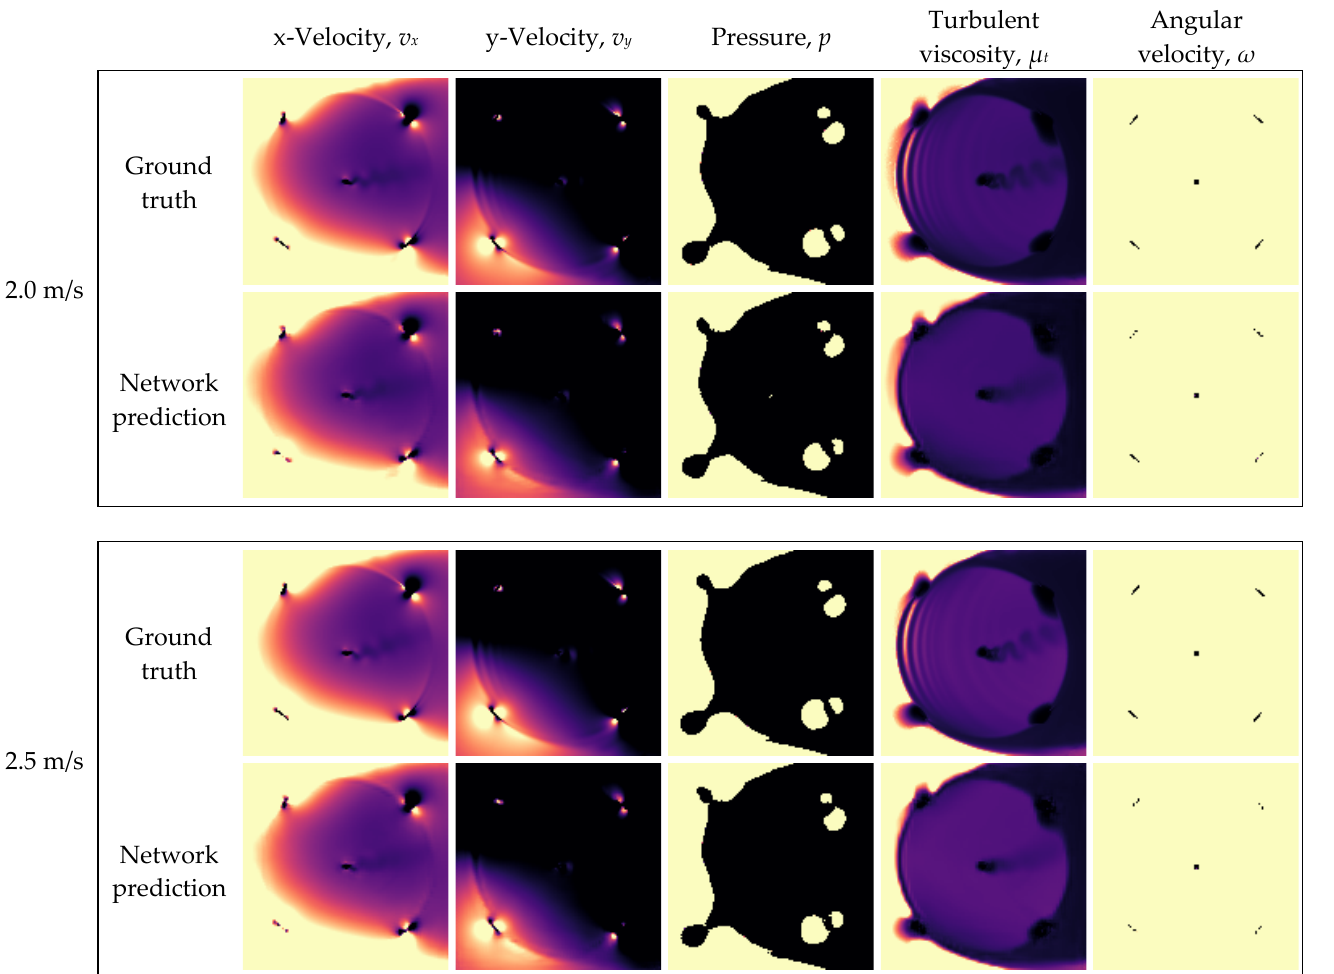
Figure 24. Ground truths and network predictions of Model 3 for the testing cases of v ∞ = 2.0 and 2.5 m/s.